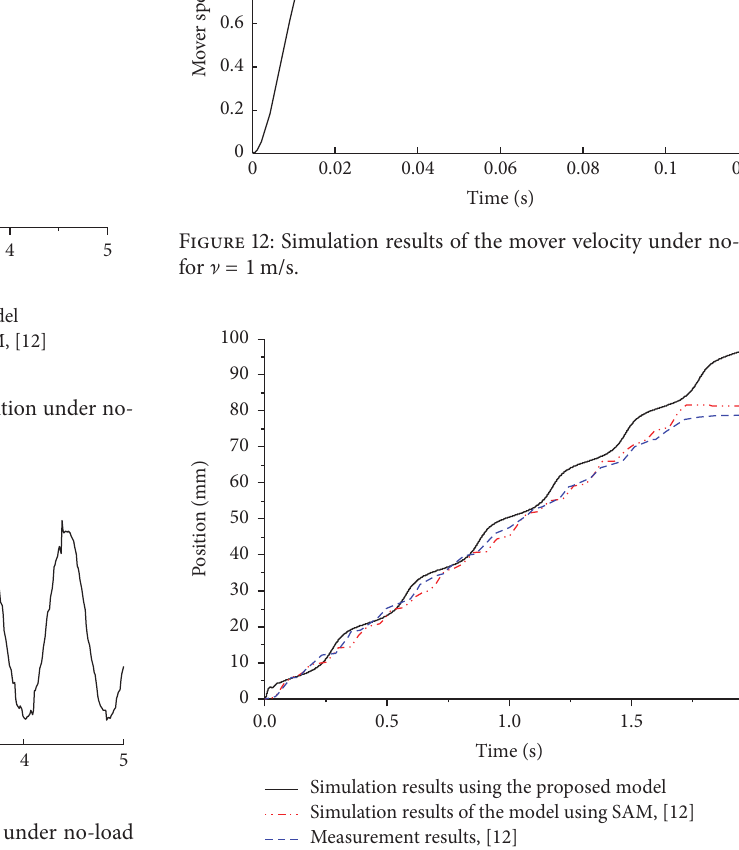
Figure 13: Transient characteristic of the mover position under an additional inertial load with the mass 𝑚 Δ = 19.2 kg for ] = 50 mm/s.